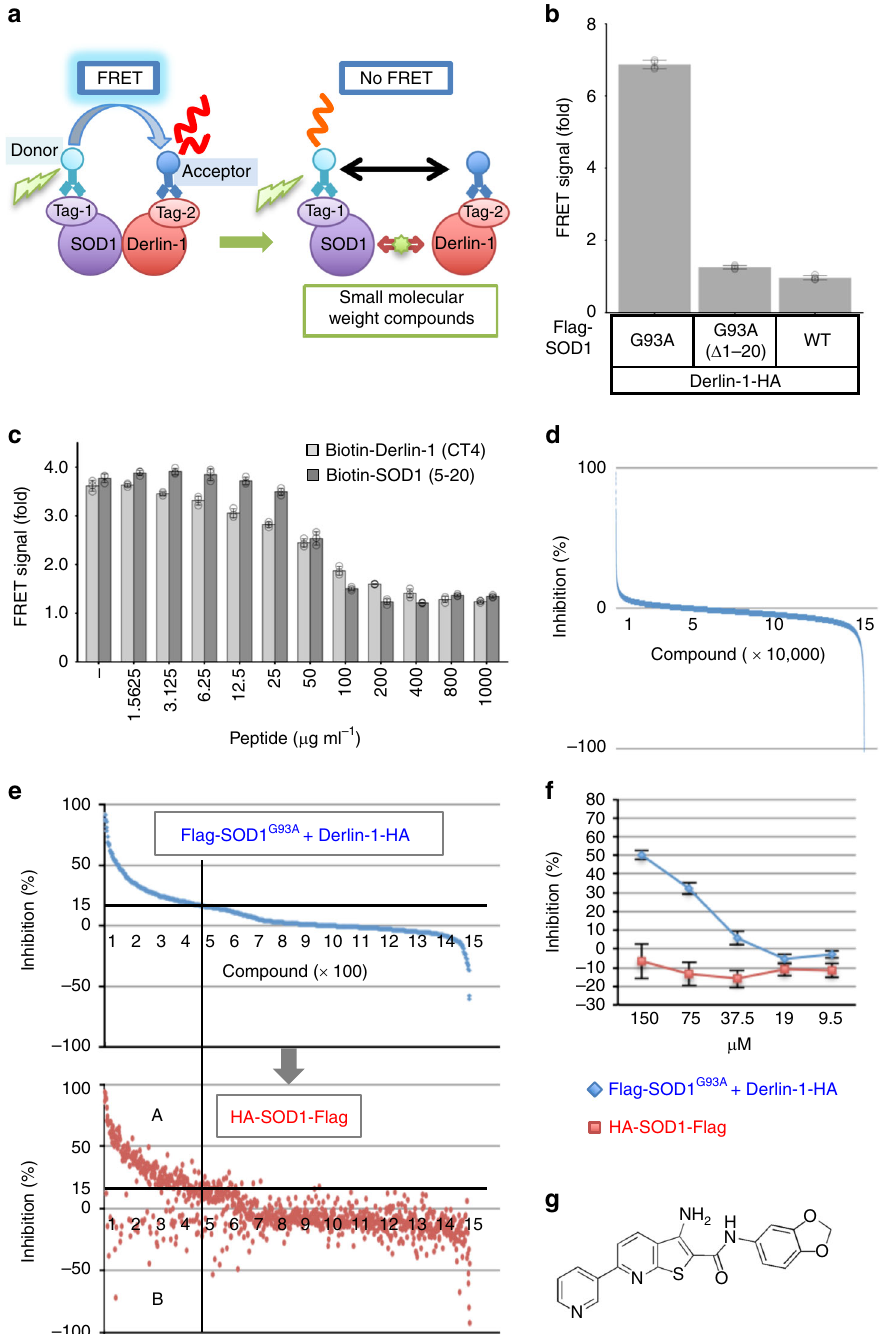
Fig. 1 Screen of small molecules for SOD1-Derlin-1 interaction inhibitors. a TR-FRET-based interaction assay model showing the case of tagged SOD1 as a target of the Eu-labeled antibody and tagged Derlin-1 as a target of the d2-labeled antibody. b , c FRET signals with Flag-Eu and HA-d2 shown as fold changes from the FRET signal in non-transfected lysate. The data are shown as the mean ± s.d. b FRET signal using lysates from HEK293A cells transfected with plasmids as indicated ( n = 4). c Competition assay of FRET signal generated by Flag-SOD1 G93A and Derlin-1-HA using indicated concentration of SOD1 (5-20) and Derlin-1 (CT4) peptide. Lysates from HEK293A cells transfected with Flag-SOD1 G93A and Derlin-1-HA were incubated with the indicated concentration of each peptide for 16 h ( n = 3). Light gray: with Derlin-1 (CT4) peptide; dark gray: with SOD1 (5-20) peptide. d Result of the fi rst screening. The compounds are presented in order of inhibition rate. e , f Blue: inhibition (%) against FRET signal generated by Flag-SOD1 G93A and Derlin-1-HA; red: inhibition (%) against FRET signal generated by HA-SOD1 WT -Flag. e Result of the second screening. The compounds are presented in order of inhibition rate against the SOD1-Derlin-1-derived FRET signal. f Result of #56 in the third screening. The data are shown as the mean ± s.d. ( n = 4). g Chemical structure of